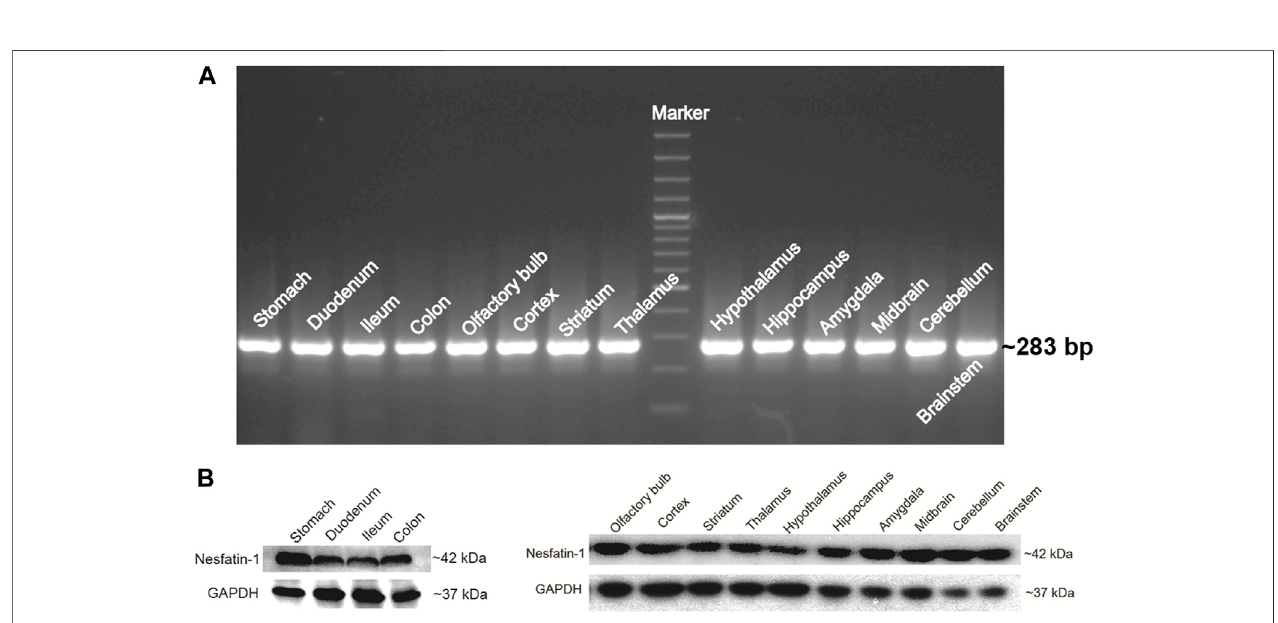
FIGURE 2 | NUCB2/nesfatin-1 expression in various tissues of Suncus murinus . (A) Conventional PCR analysis of NUCB2 mRNA (~283 bp) in the stomach, gut and brain. (B) Western blot analysis of nesfatin-1 protein (~42 kDa) in the stomach, gut and brain.